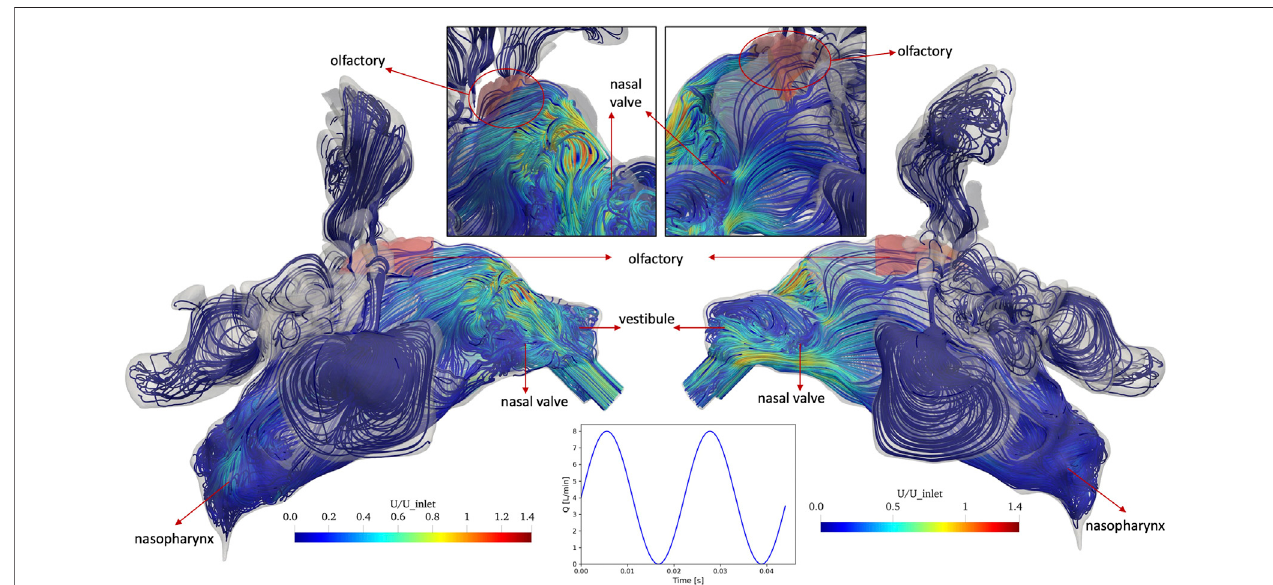
FIGURE 5 | Streamlines of the normal(-ized) air velocity U in the nasal cavity for pulsatile inlet fl ow of 4 L/min with a frequency of 45 Hz (oscillation period T (cid:2) 22.2 ms) at T/2ofthelast modeledpulse ( t (cid:2) 1.98 s),whereT/2 (middle ofcycleofair fl owpulsation)represents theconditionwhere theinlet fl owisequal tothe average fl ow rate of the pulsatile fl ow pro fi le. Again, the olfactory epithelium region is shaded in